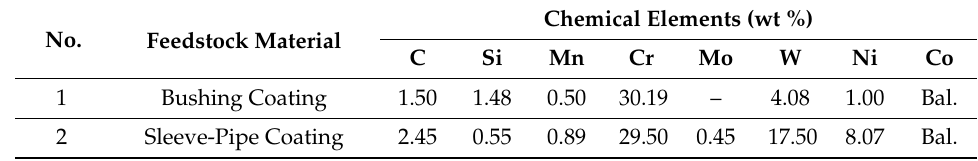
Table 1. Compositions of the powder for both bushing and sleeve pipe.